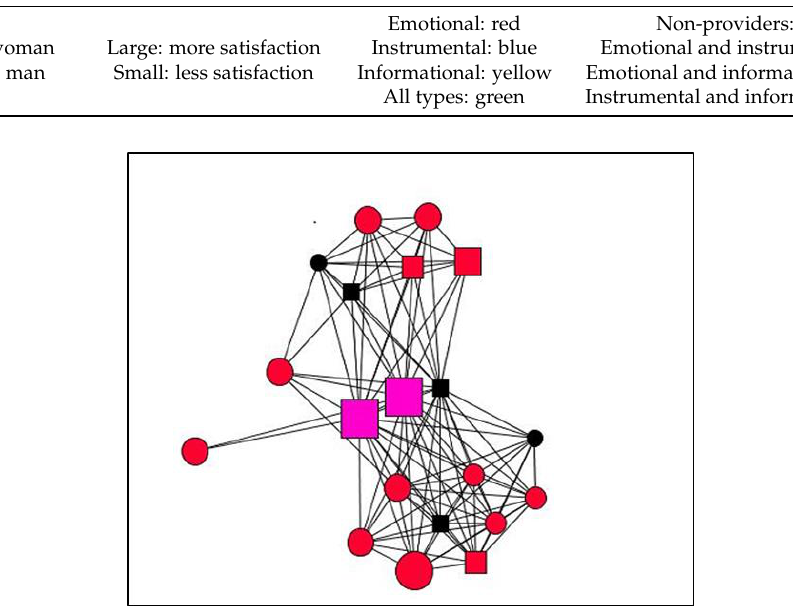
Figure 1. Graph Case 2. Women, 31 years old, 8 years with chronic pain.